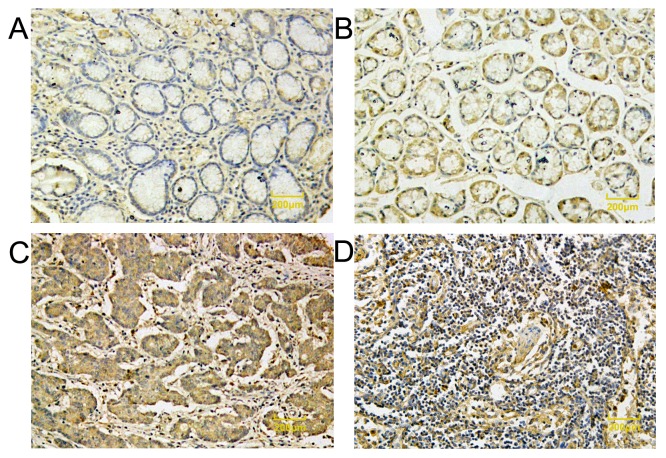
Analysis of Legumain protein expression by immunohistochemistry in normal gastric mucosa, gastric cancer and lymph node metastasis.(a) (b) Legumain expression exhibited negative or diffuse weakly positive staining in the cytoplasm in distant normal mucosa. (c) Legumain exhibited strong vesicular positivity in the cytoplasm in primary gastric cancer compared with those of adjacent normal mucosa. Vesicles were scattered in the cytoplasm. (d). Legumain also overexpressed in metastasis lymph nodes. (magnification ×100).